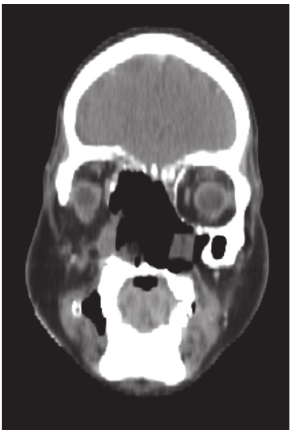
Figure 9: Coronal cut of contrast enhanced CT paranasal sinus showing postoperative changes and absence of any